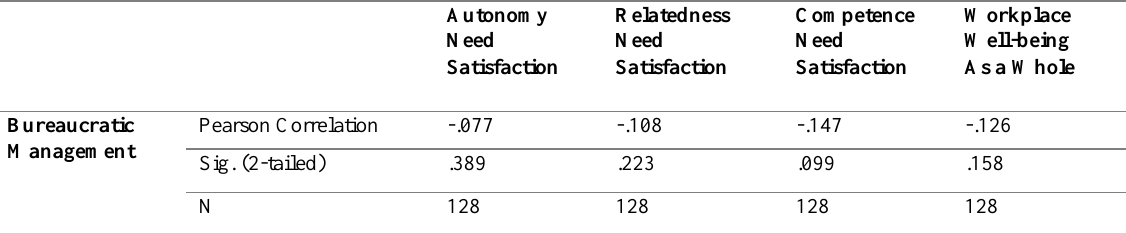
Table 6: Relationship between Bureaucratic Management and Workplace